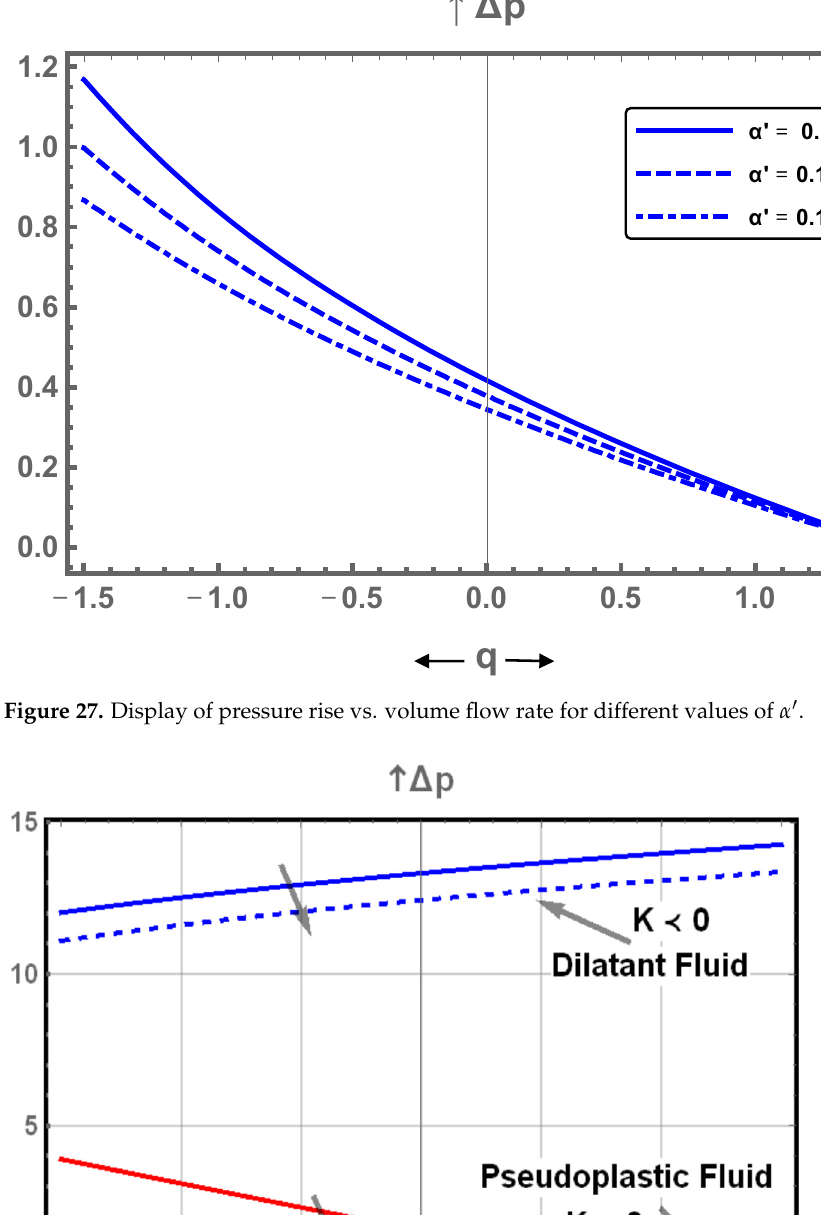
Figure 28. Display of pressure rise vs. volume flow rate for pseudoplastic and dilatant fluids.